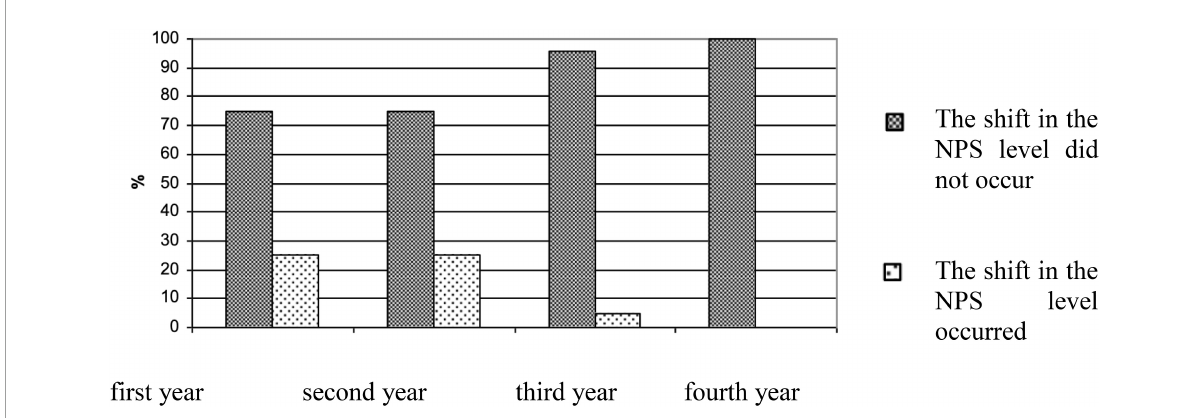
FIGURE1 Frequency of occurrence of a changed and unchanged level of neuropsychic strain in psychology students of the first age subgroup during the academic day (in %).